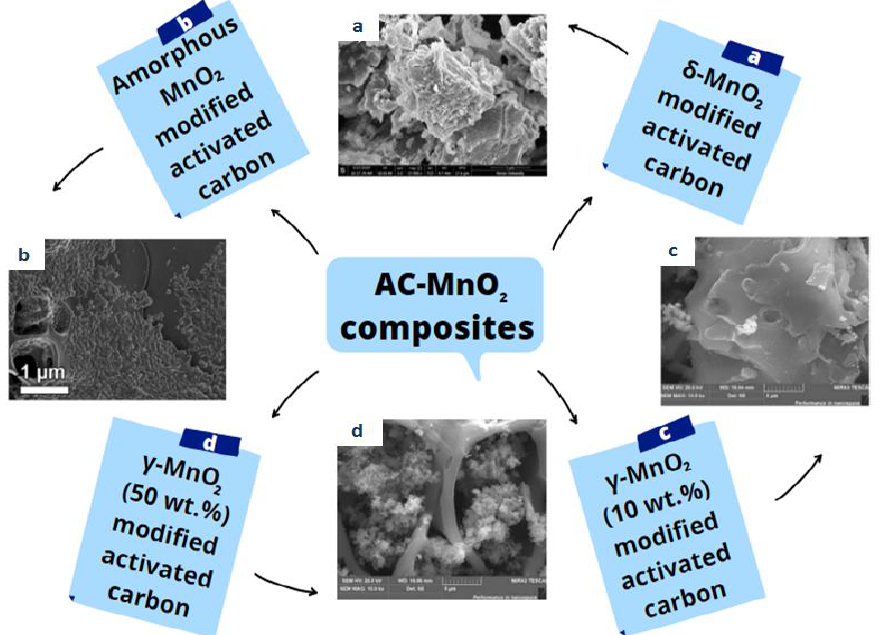
Figure 3. Scheme of AC/MnO 2 -based composite types: ( a ) δ -MnO 2 -modified activated carbon. This figure is reprinted from [99], with permission from Elsevier B.V., 2022; ( b ) amorphous MnO 2 -modified activated carbon. This figure is reprinted from [95], with permission from Elsevier, 2022; ( c ) γ -MnO 2 (10 wt.%)-modified activated carbon. This figure is reprinted from [100], with permission from corresponding author Prof. Xiaolan Song; ( d ) γ -MnO 2 (50 wt.%)-modified activated carbon. This figure is reprinted from [101], with permission from the corresponding author, Prof. Xiaolan Song. This figure was created by using the Canva application.